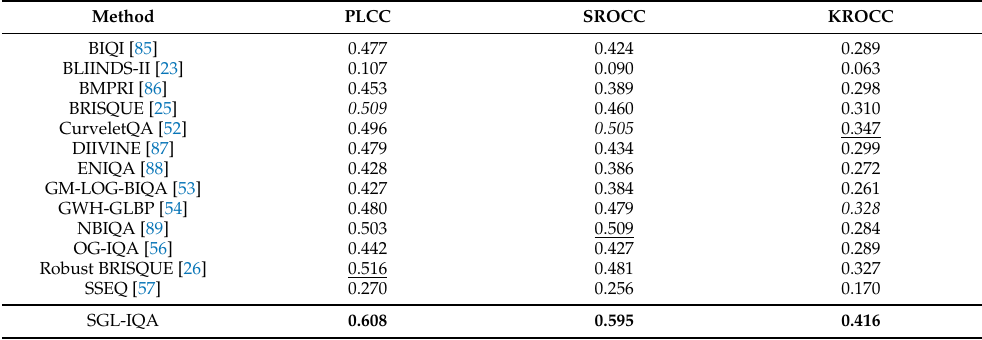
Table 11. Numerical results of the cross-database test. The considered algorithms were trained on the entire KonIQ-10k [11] database and tested on the entire CLIVE [10] database. The best results are given in bold, the second-best results are underlined, and the third-best results are given in italics.